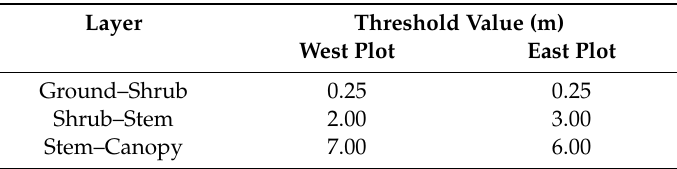
Table 2. Threshold values of height that define the four strata.